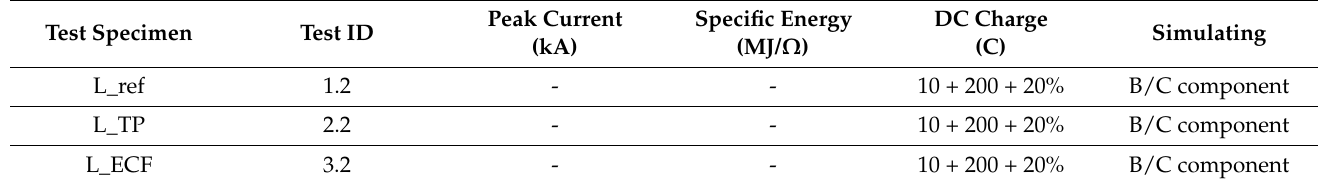
Table 5. T02, 2A–B/C Component.